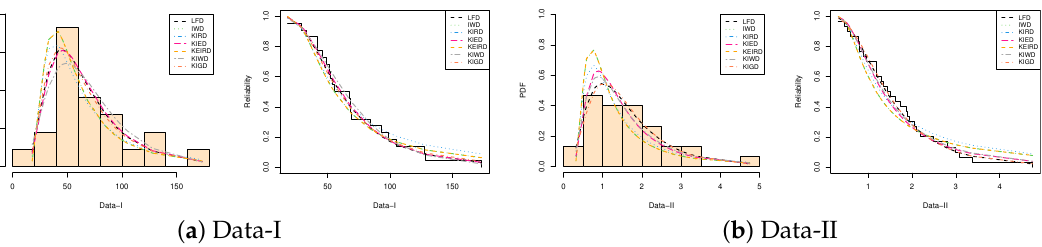
Figure 9. Plots of the fitted PDFs ( left ) and fitted RFs ( right ) of LFD-TII and its competing models based on data sets I and II.